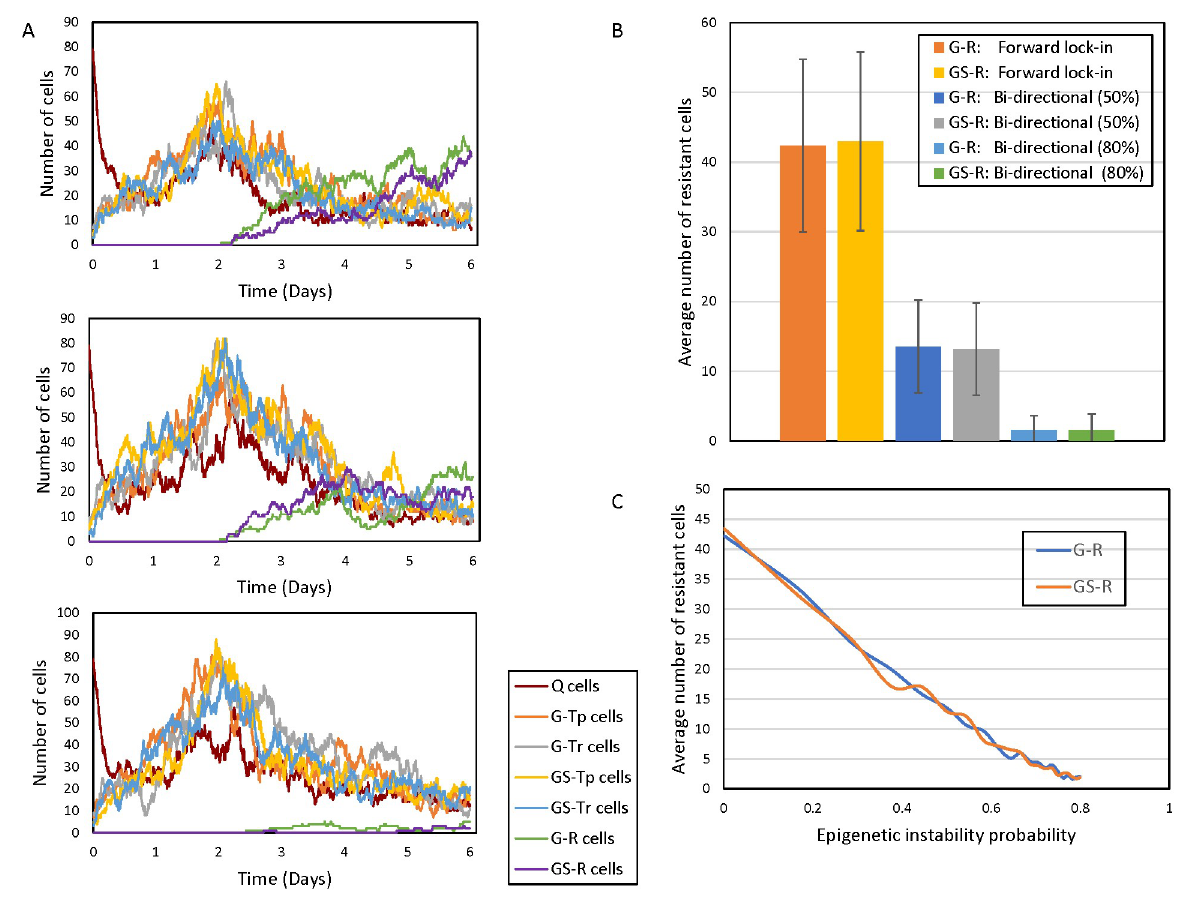
Fig 4. Cell population dynamics for the multi-step model. (A) Top panel: Forward lock-in multi-step process with drug introduced at t = 2 days. Middle panel: Bi-directional multi-step process with moderate epigenetic instability (50% probability of switch turning on ➔ off). Bottom panel: Bi- directional multi-step process with high epigenetic instability (80% probability of switch turning on ➔ off) (B) Average ( ± standard deviations) number of resistant cells at t = 6 days following 2000 independent simulations. The values 50% and 80% in the legend are the probability of switch turning on ➔ off. (C) The average number of resistant cells (GS-R plus G-R) as a function of increasing epigenetic instability (probability of switch turning on ➔ off) in a multi-step bi-directional